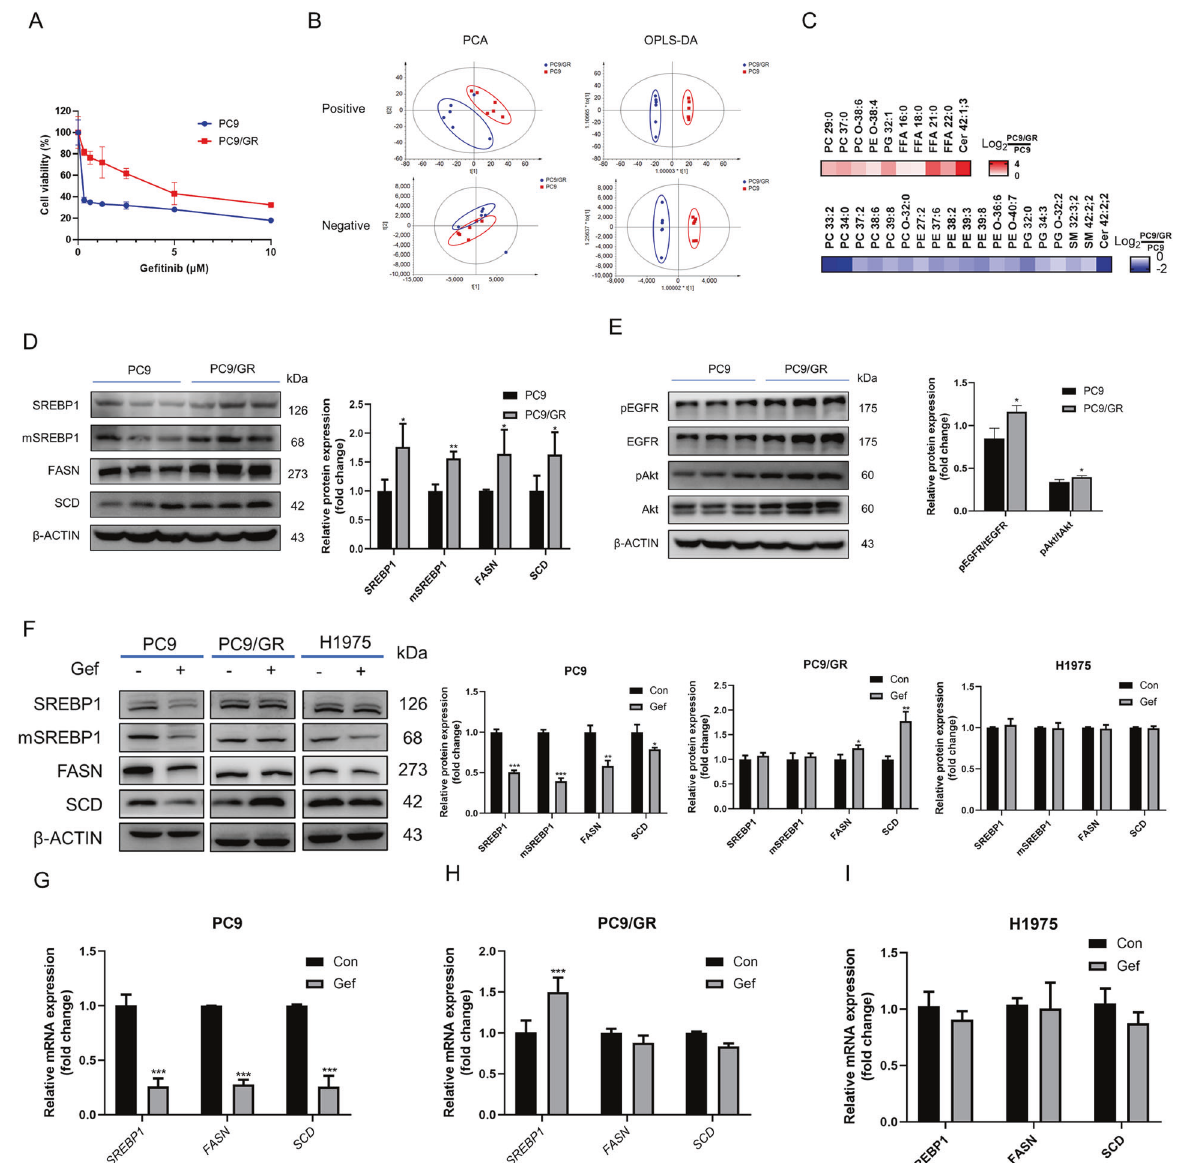
Fig. 1 Effects of ge fi tinib on lipid metabolism involve SREBP1. A PC9 and PC9/GR cells were treated with ge fi tinib for 72 h, and the cell viability was measured by CCK8. B Lipidomic analysis on PC9 and PC9/GR cells in positive and negative ion modes, respectively. PCA and OPLS-DA score plots of lipidomic pro fi les obtained from LC-MS/MS. C Comparison of the changed lipids between PC9/GR and PC9 group. Heatmap shows the ratios of phospholipid species abundance in cells. Species are represented by the total number of fatty acid carbons and unsaturated carbons, which are linked by a colon. D The protein expression level of SREBP1 and relevant protein were assessed in PC9 and PC9/GR cells. E The protein expression level of EGFR and relevant protein were assessed in PC9 and PC9/GR cells. F Western Blot analysis of PC9, PC9/GR, and H1975 cells treated with ge fi tinib. G – I The mRNA levels of SREBP1, FASN , and SCD were determined by RT-qPCR. Data are expressed as the mean ± SD ( n = 3). * P < 0.05, ** P < 0.01, *** P < 0.001 compared with